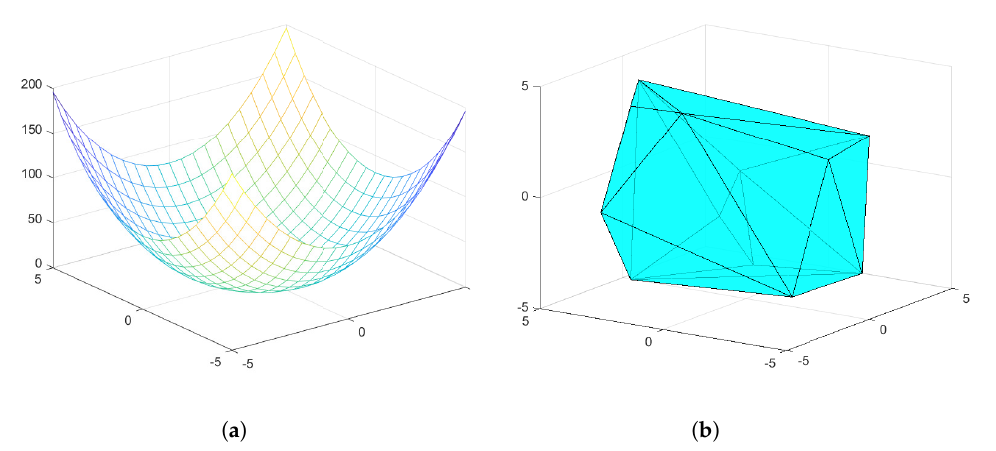
Figure 1. Two examples of a convex function landscape and convex hull. ( a ) This is an example of a composed convex function f ( x 1 , x 2 ) = (( x 1 ) 2 + ( x 2 ) 2 + 0.1 ) log (( x 1 ) 2 + ( x 2 ) 2 + 0.1 ) ( b ) This is an example of a convex hull when d =